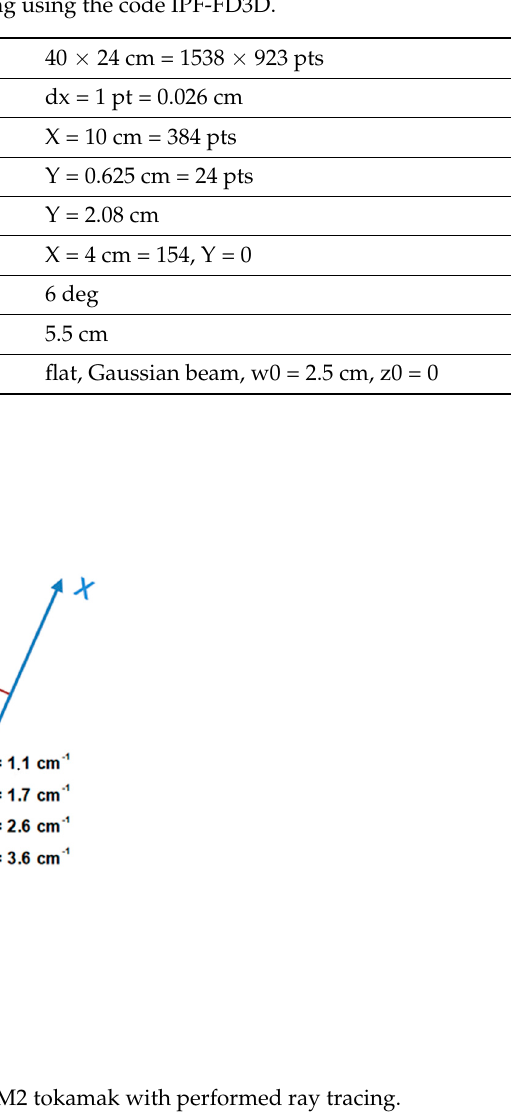
Table 1. Parameters of the performed modelling using the code IPF-FD3D.